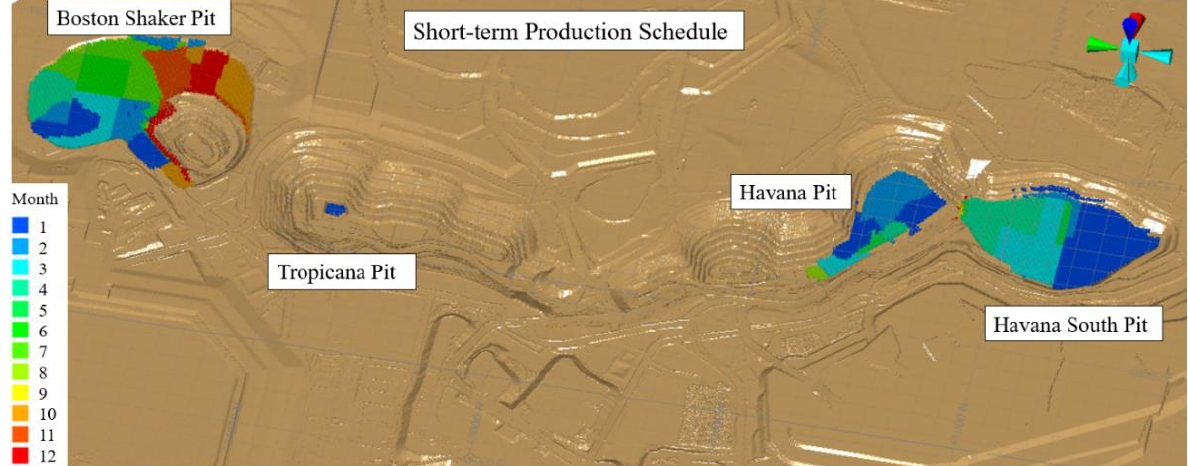
Figure 9. Example of a monthly short-term production schedule in the Tropicana Gold mining com- plex.